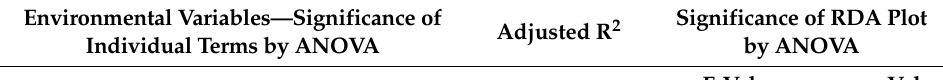
Table 3. Results from canonical redundancy analysis (RDA) of Hellinger-transformed species data and selected environmental variables. Significance of individual terms determined by analysis of variance (ANOVA) on RDA. *** p ≤